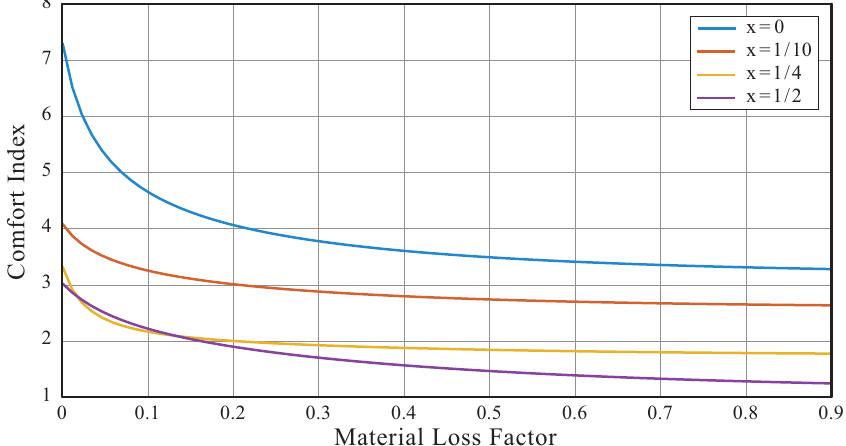
Figure 12. Comfort index at four locations on the beam versus η with outstretched upper